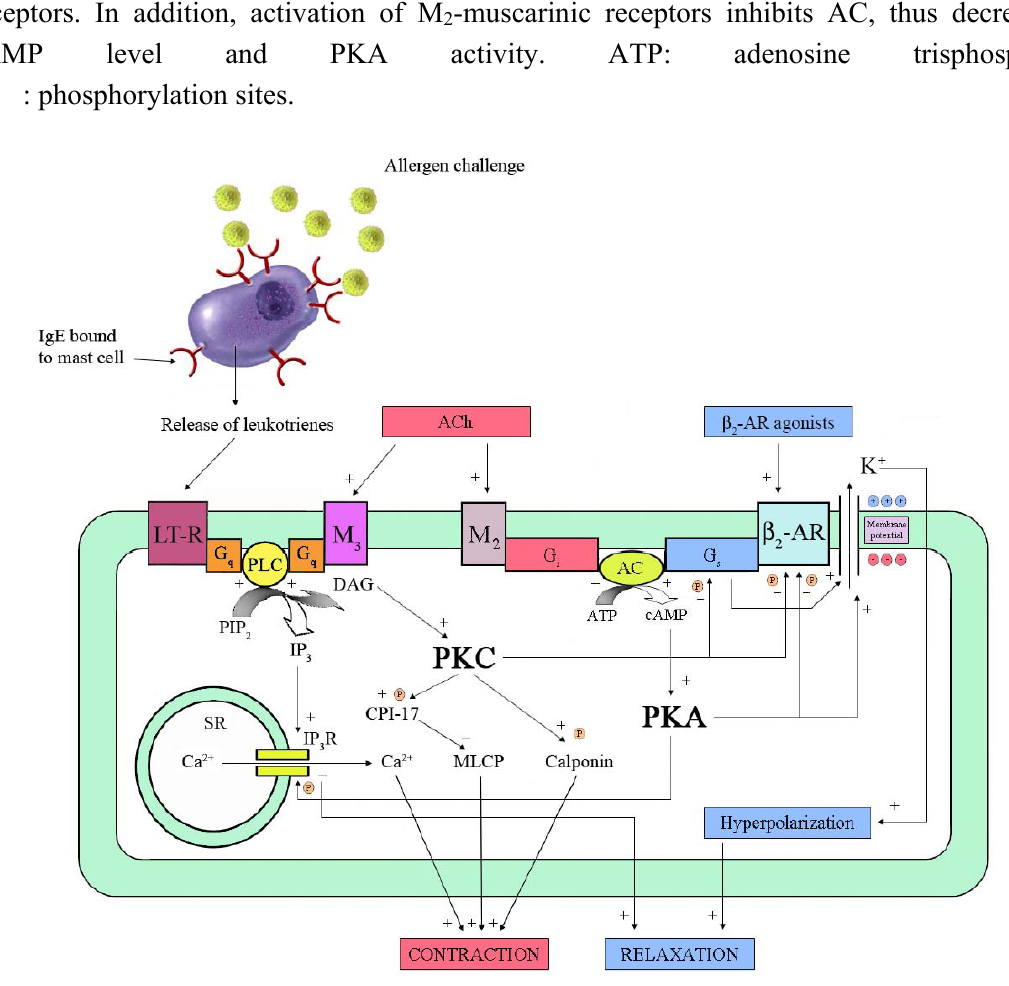
Figure 2. Mechanisms of relaxation and β -adrenoceptor ( β -AR) desensitization in airway 2 2 smooth muscle (ASM). The binding of a specific agonist to β -AR stimulates the 2 -protein, which activates adenylyl cyclase (AC). The resulting increase of receptor-coupled G s cyclic 3',5'-adenosine monophosphate (cAMP) activates protein kinase A (PKA), which phosphorylates inositol 1,4,5-trisphosphate receptor (IP R) of sarcoplasmic reticulum (SR) and 3 opens Ca 2+ -activated K + (BKCa) channels, thus leading to relaxation. However, activated PKA -AR, uncoupling it from G -protein. Exposure of sensitized mast-cells to phosphorylates β 2 s allergen causes release of leukotrienes (LT). Their interaction with the specific receptor, i.e. , LT-R, activates a G -protein, which increases phospholipase C (PLC) activity. PLC catalyzes q ), which produces IP and the hydrolysis of phosphatidylinositol 4,5-bisphosphate (PIP 2 3 diacylglycerol (DAG). IP leads to contraction by increasing release of Ca 2+ from SR while 3 DAG activates protein kinase C (PKC). The latter phosphorylates several substrates like calponin and CPI-17, which is an inhibitor of myosin-light-chain phosphatase (MLCP). In -AR and G -protein. A similar cascade of events seems to addition, PKC phosphorylates both β 2 s -muscarinic occur in response to acetylcholine (ACh) released by cholinergic nerves through M 3 -muscarinic receptors inhibits AC, thus decreasing receptors. In addition, activation of M 2 cAMP level and PKA activity. ATP: adenosine trisphosphate; : phosphorylation